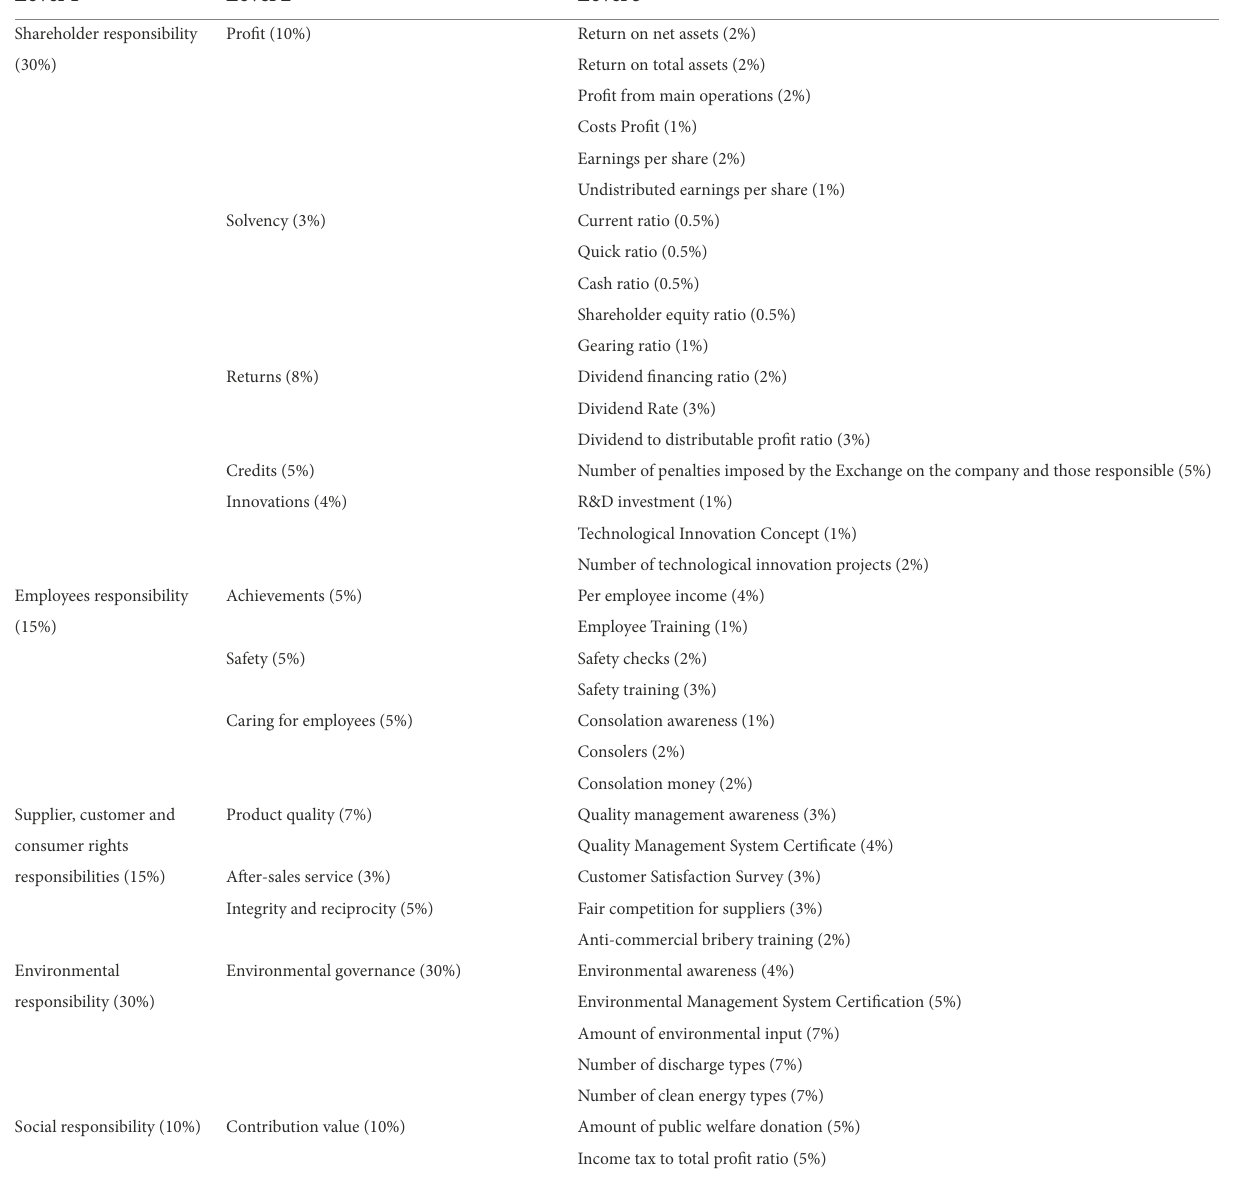
TABLE 2 The components and weights of the Hexun ESG